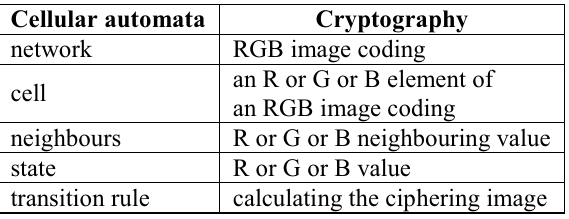
Table 2. Correspondence between cellular automata and cryptography according to S2CA-EX.